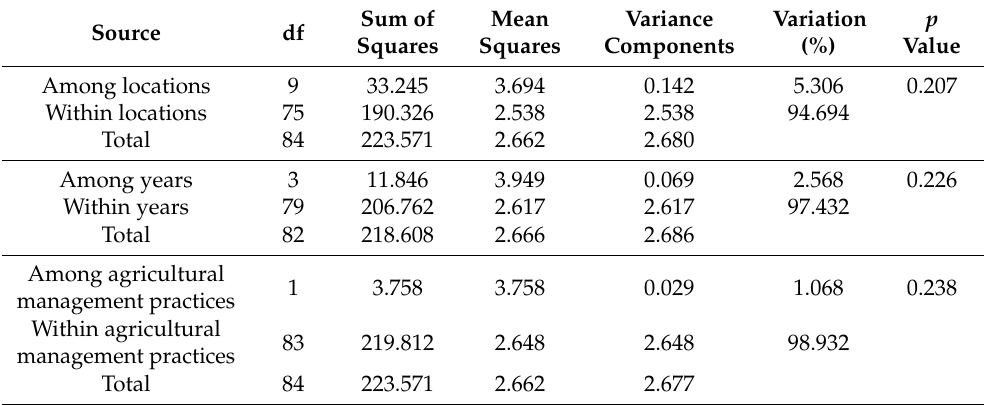
Table 3. Analysis of molecular variance (AMOVA) of P. infestans isolates grouped into locations, years, and agricultural management practices (clone corrected).